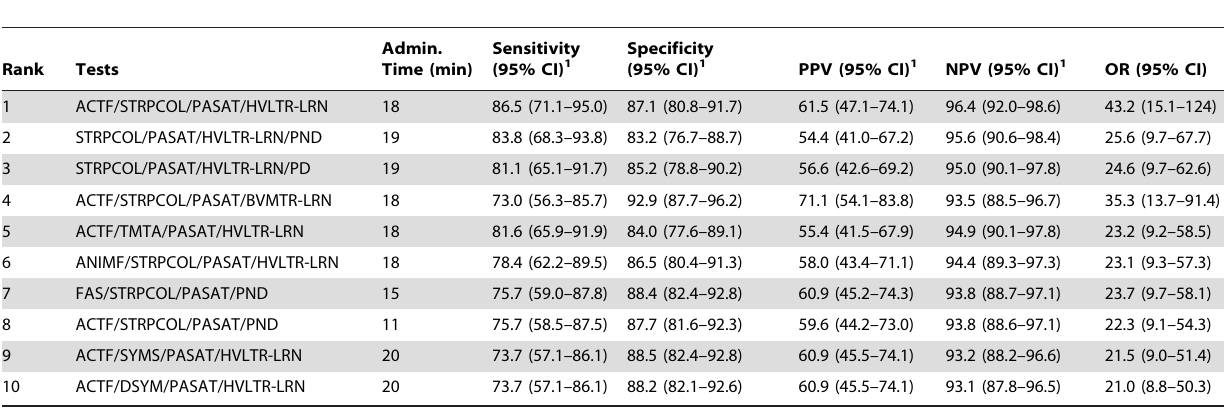
Table 4. Top 10 4-test combinations, ranked according to sum of sensitivity and specificity compared to a 120 minute global neuropsychological battery.